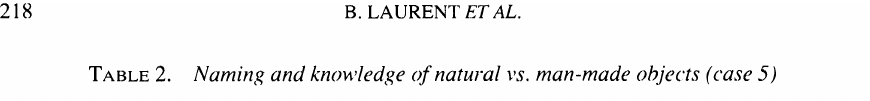
TABLE 2. Naming and knowledge of natural vs. man-made objects (case 5) Vegetables Animals Cars Tools Clothes Personalities Business Colors and